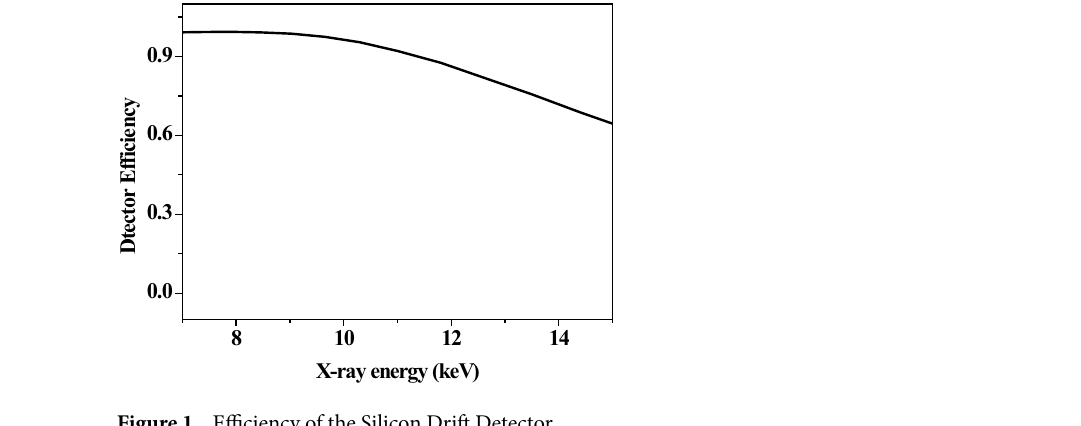
Figure 1. Efficiency of the Silicon Drift